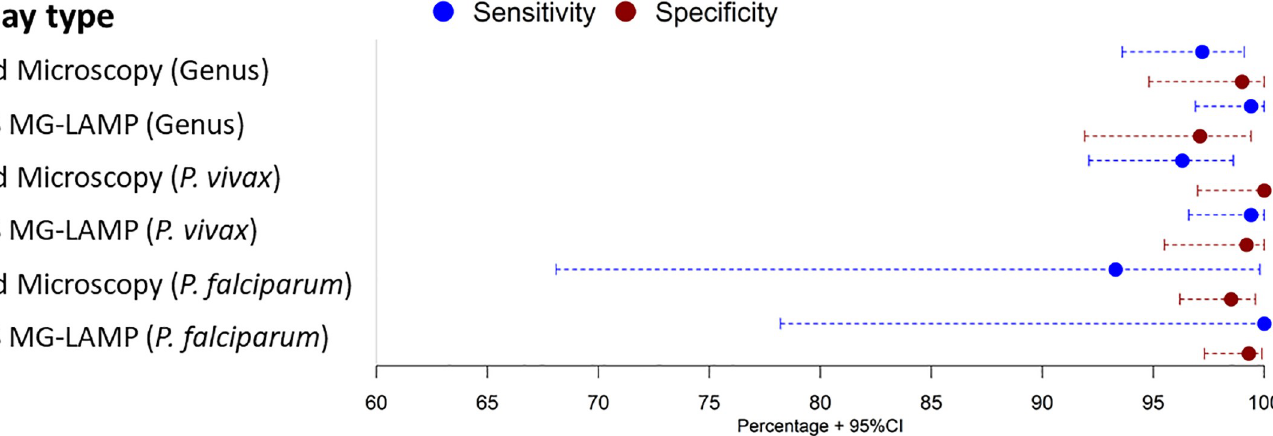
Fig 3. Sensitivity (blue), specificity (red) and 95% confidence intervals for genus and species detection of field microscopy, expert microscopy and the B&S